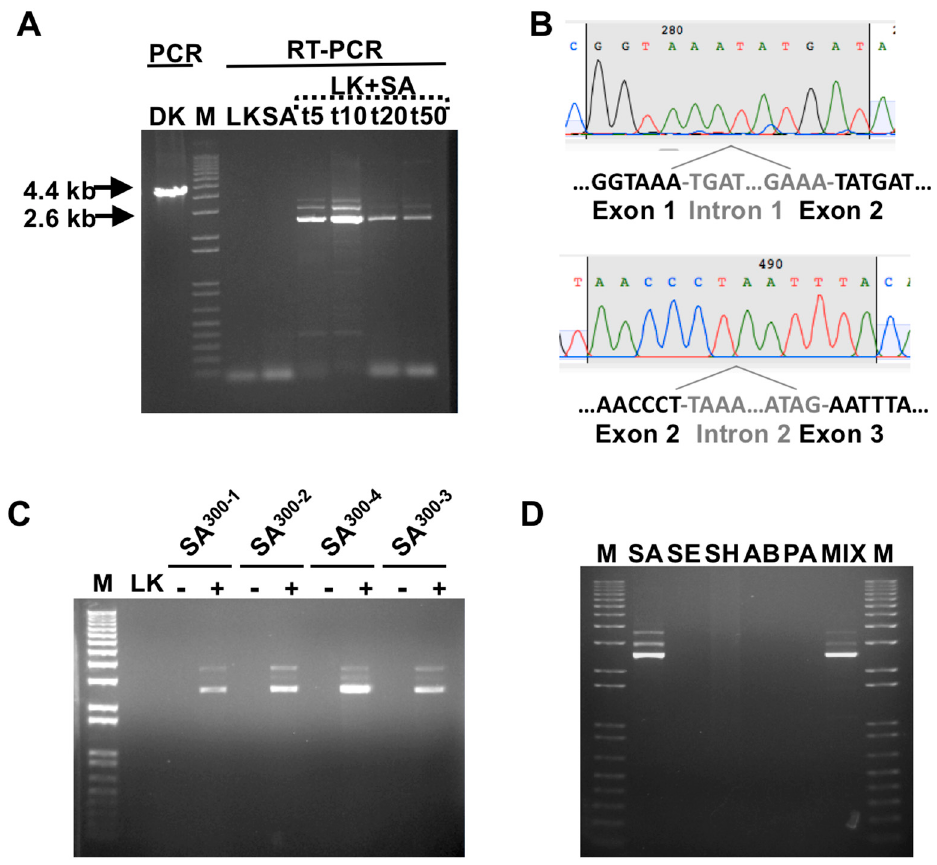
Figure 2. Page-mediated molecular detection (PMMD) assay by two-step RT-PCR. ( A ) Gel electrophoresis results of PCR from reverse-transcribed phage K lysates (LK), SA cells (SA), and SA cells infected with phage K (SA + LK) for 5, 10, 20, and 50 minutes. PCR from phage K genomic DNA (DK) and a commercial size marker (M) are also shown. The approximate sizes of the major bands are indicated with arrows. Minor upper size band(s), correspond to unspliced (pre-mRNA) and / or incorrectly spliced RNAs. ( B ) Sanger sequencing chromatograms of the 2.6 kb RT-PCR band shown in ( A ) using primers specific for the predicted exon–exon junctions. The exon junction (black font) and intervening introns (gray font) sequences are also shown. ( C ) Gel electrophoresis of PMMD results, + lanes, using four USA300 strains (SA300-1 to -4, corresponding to clinical isolates SA1415.COI, SA1012.COI, SA1107.COI, and SA1019.COI, respectively). Controls without infection, - lanes, and with phage K lysate without cells (LK), as well as a DNA size marker (M), are also shown. ( D ) Gel electrophoresis of PMMD results from di ff erent bacteria incubated with phage K (SA: Staphylococcus aureus , SE: Staphylococcus epidermidis , SH: Staphylococcus haemolyticus , AB: Acinetobacter baumannii , and PA: Pseudomonas aeruginosa , MIX: mixture of all the bacterial species), and M: DNA size marker.